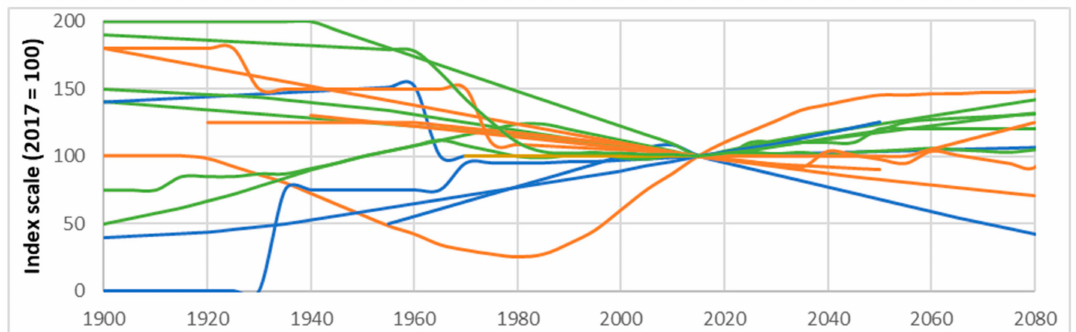
Figure 7. Sketched trends of flexibility over time, with y axis as an index scale, 2017 = 100. Blue = flexibility is the ability to control or steer the system, orange = flexibility is the ability to deal with extreme situations, green = flexibility is keeping options for the future open. Some lines do not cover the entire